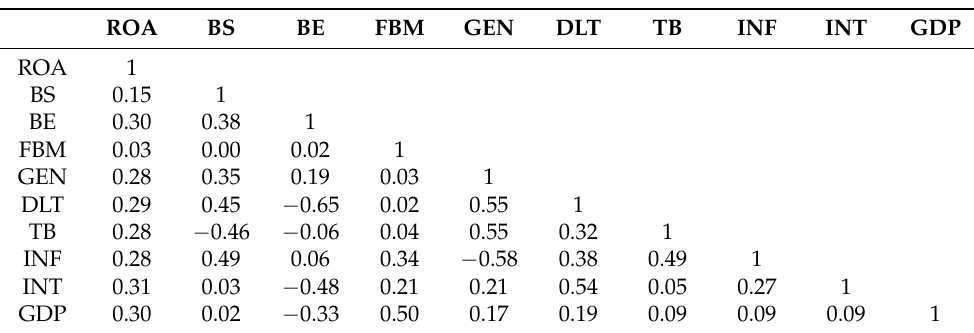
Table 4. Correlation